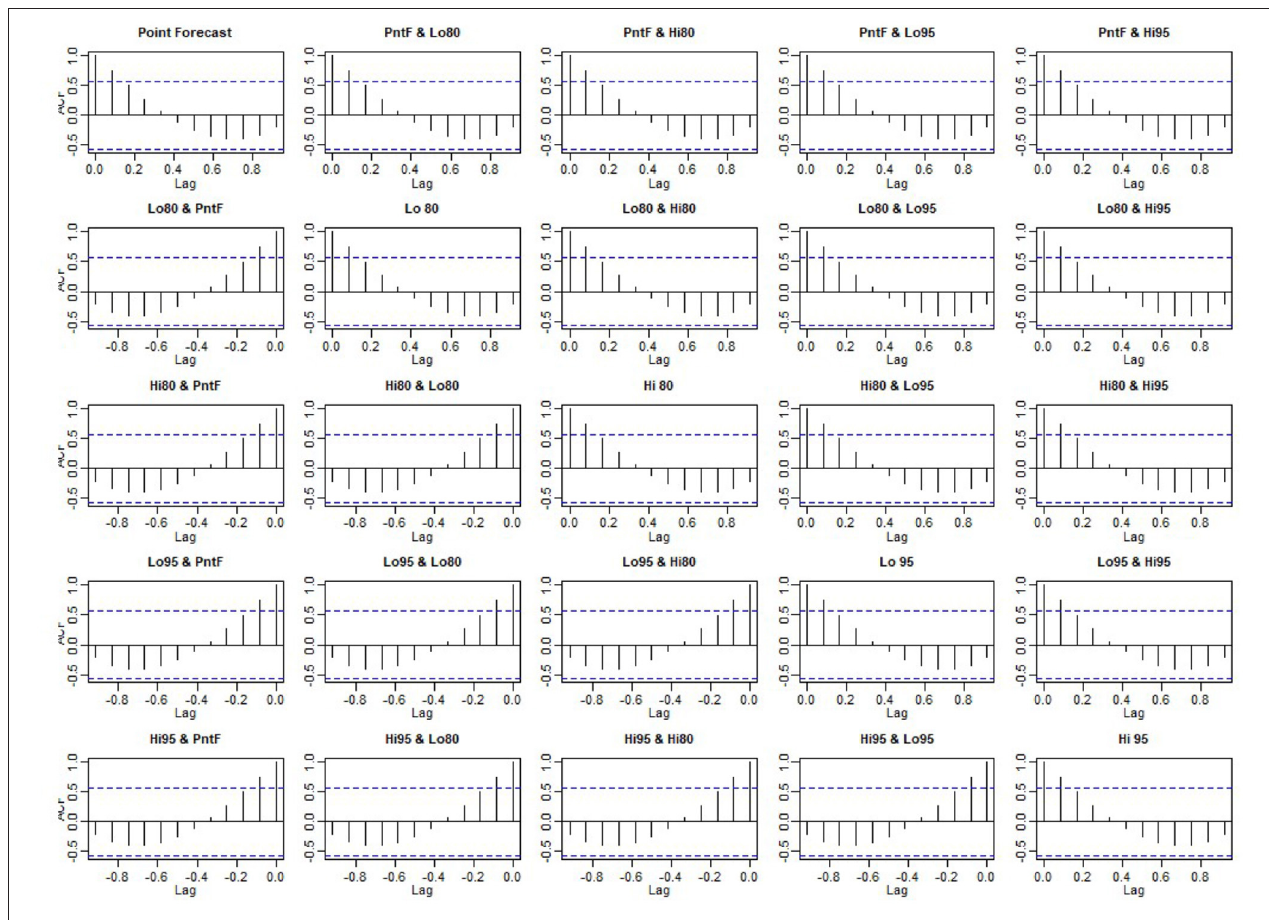
FIGURE 6 | Detailed autocorrelation